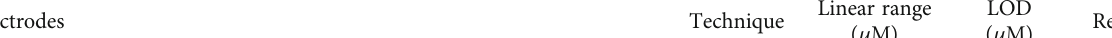
Table 2: Comparison of the analytical performance of the di ff erent modi fi ed electrodes for the determination of DCF. Electrodes